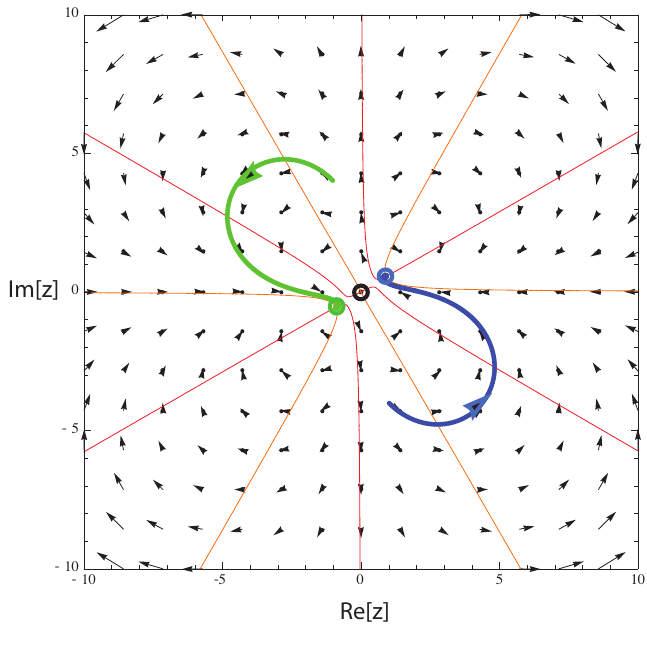
Figure 1. Vector field plot with isoclines (red lines) and fixed points (filled circles). Two solutions emanating from different initial conditions (green, blue) illustrate that a bifurcation from a central previously stable, fixed point to two stable fixed points has occurred ( ω µ = 0 . 5 , F = 0